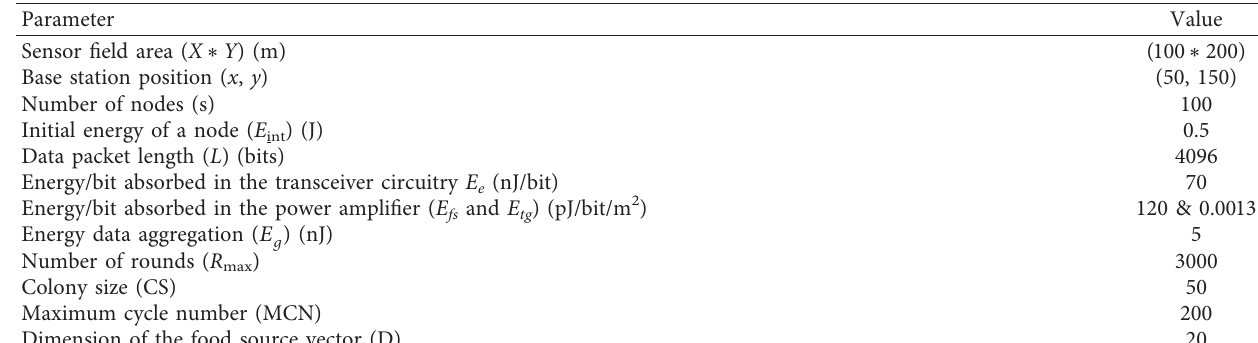
Figure 2: Radio hardware model. Table 1: Parameters of PBC-CP